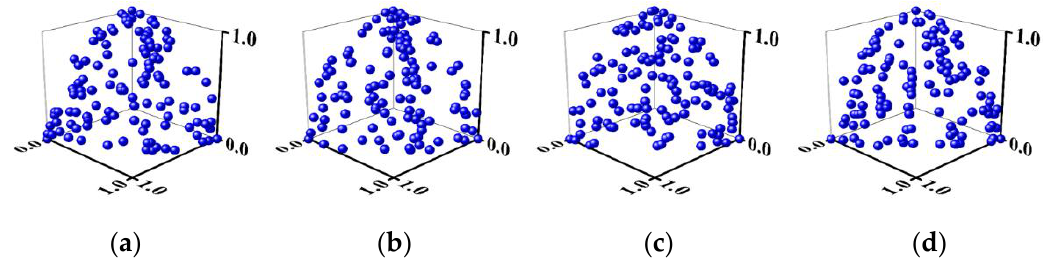
Figure 4. Pareto front of 3-objective DTLZ3 for problems ( a ) NSGA-II/CSDR 1 ( b ) NSGA-II/CSDR 2 ( c ) NSGA-II/CSDR 3 ( d ) NSGA-II/CSDR 4.